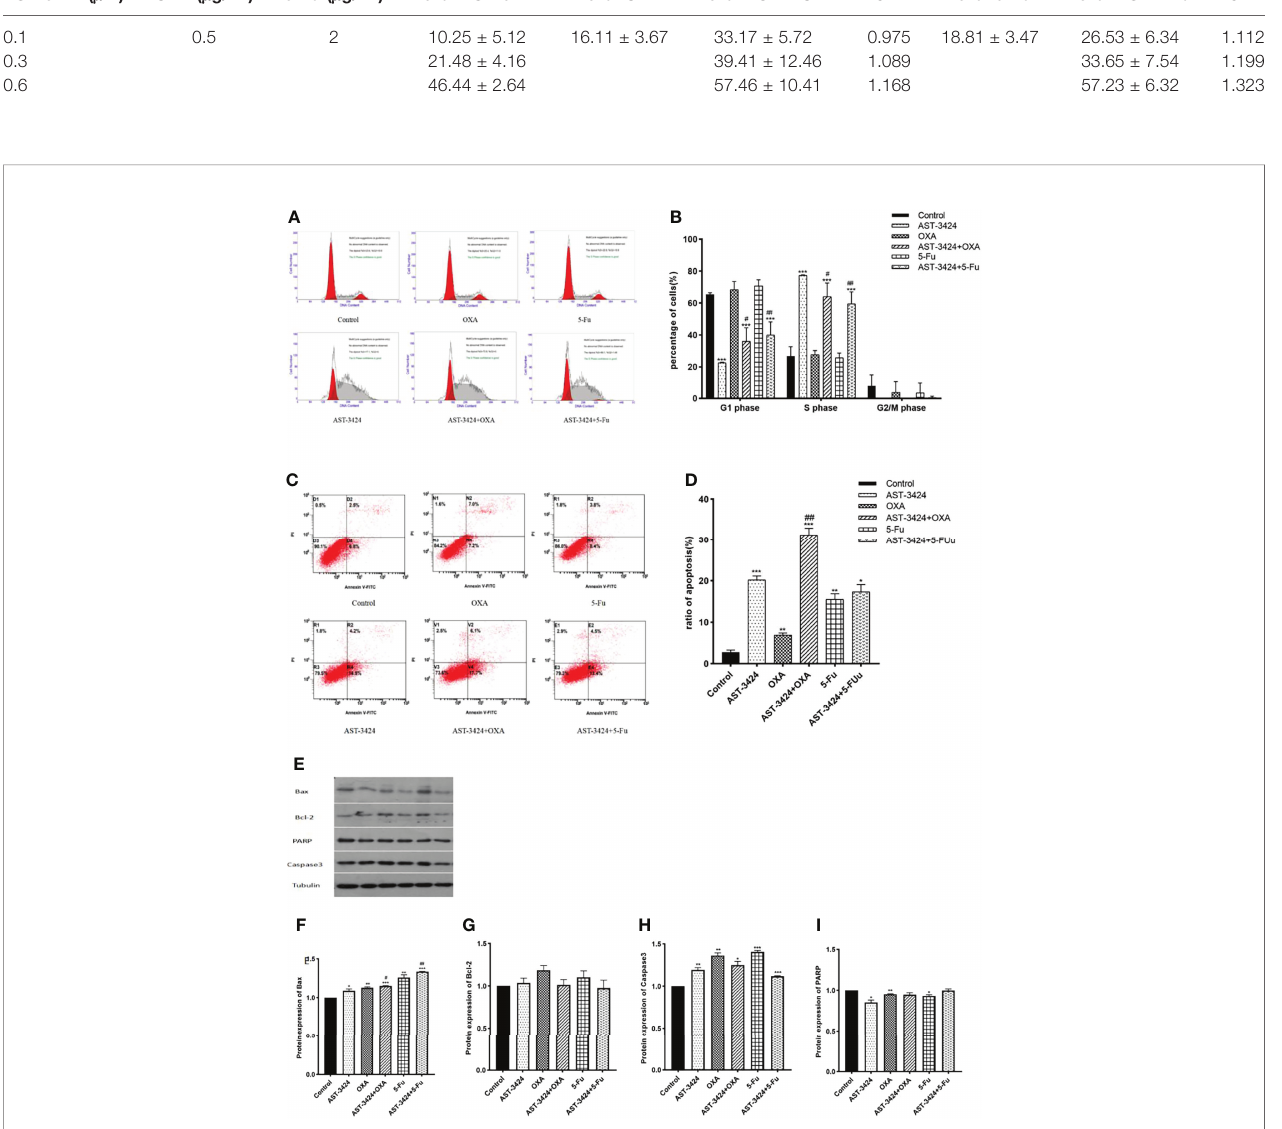
FIGURE 3 | Cell cycle arrest effect and apoptosis induction effect of AST-3424, OXA, and 5-Fu as a single agent or in combination with AST-3424 on HepG2 cells. (A) DNA content-based cell cycle of HepG2 cells after treatment with AST-3424 (0.05 m M), OXA (0.02 m g/ml), and 5-Fu (0.3125 m g/ml) alone or in combination was analyzed using fl ow cytometry. (B) Percentage of cells in the S phase of HepG2 cells after treatment with AST-3424 (0.05 m M), OXA (0.02 m g/ml), and 5-Fu (0.3125 m g/ml) alone or in combination with AST-3424. (C, D) Flow cytometry histograms of HepG2 cells after 48 h of treatment with AST-3424 (0.05 m M), OXA (0.02 m g/ml), and 5-Fu (0.3125 m g/ml) alone or in combination with AST-3424; the samples were detected using AV/PI double-staining method. The percentage of apoptotic cells was calculated, and the results are shown in the bar graph. (E – I) The expression levels of anti-apoptotic proteins, Bax, Bcl-2, Caspase3, and PARP, in HepG2 cells of different treatments were detected by Western blot, and the relative optical densities of the proteins were analyzed by ImageJ. All results are expressed as mean ± SEM of three independent experiments. * p < 0.05, ** p < 0.01, *** p < 0.001, compared to the control group; # p < 0.05, ### p < 0.01, ### p < 0.001, the combination group compared to the AST-3424 monotherapy